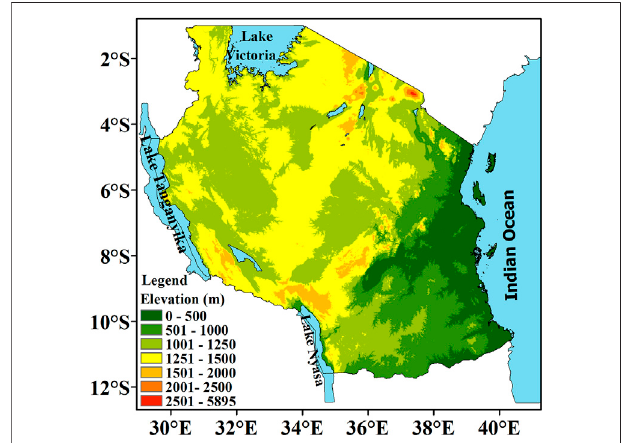
FIGURE 1 | Topographical map of Tanzania showing elevation distribution over the